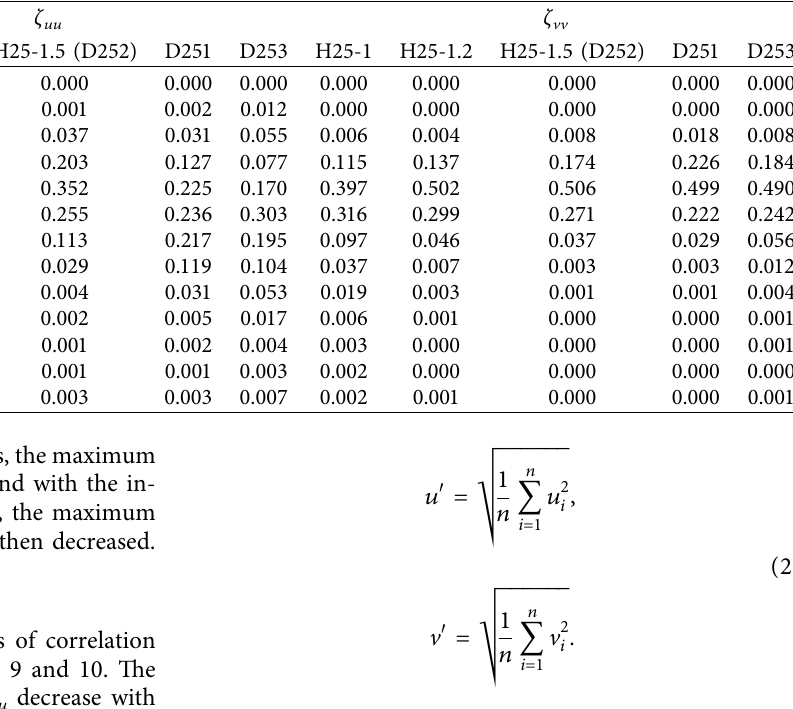
Table 3: The value of ζ uu and ζ vv in different working